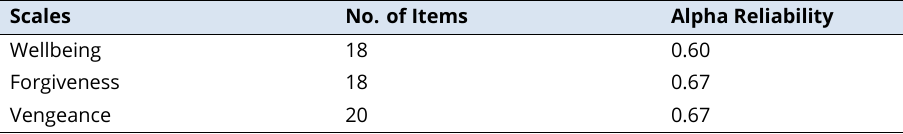
A l pha reliability of the scales